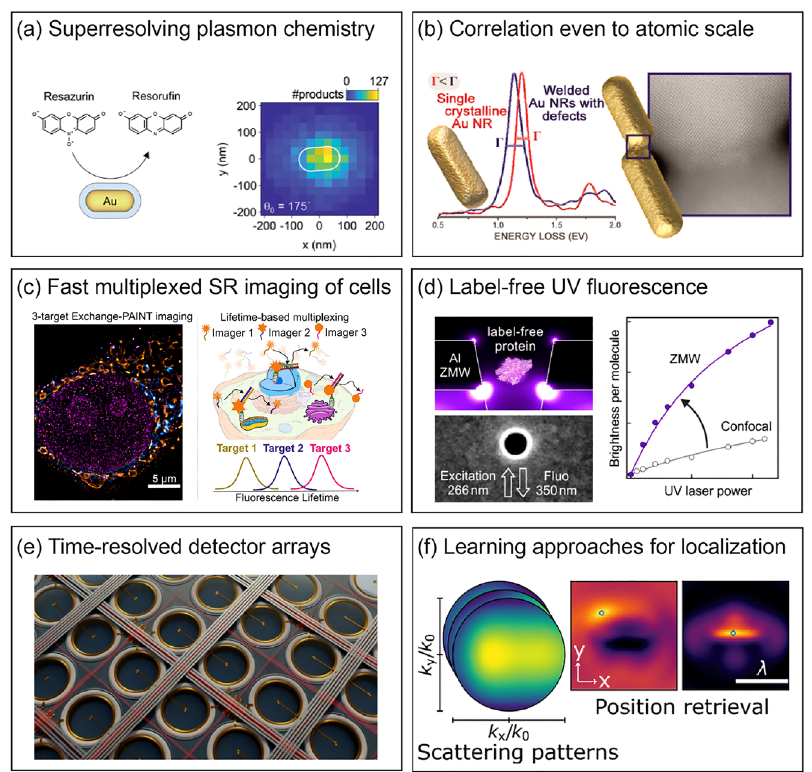
Figure 12: Outlook for SMLM in nanophotonics and biophysics. (a) Super-resolved plasmon chemistry at the single-molecule level (adapted from [194]). (b) Correlative microscopy at the atomic scale on gold nanorods (adapted from [195]). (c) Super-resolved in cellulo biochemistry (adapted from [83]). (d) Enhancing label-free UV fluorescence of proteins with ZWGs (adapted from [44]). (e) Artist view of a SPAD array (adapted from [196]). (f) Learning approaches to localization based on a library of diffraction patterns measured by Fourier microscopy (adapted from